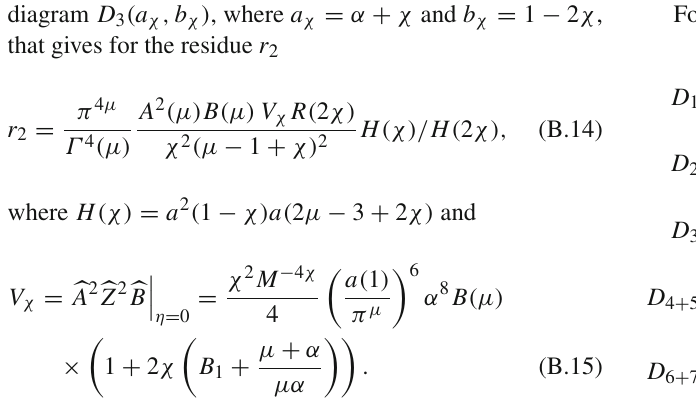
diagram D 3 ( a χ , b χ ) , where a χ = α + χ and b χ = 1 − 2 χ , that gives for the residue r